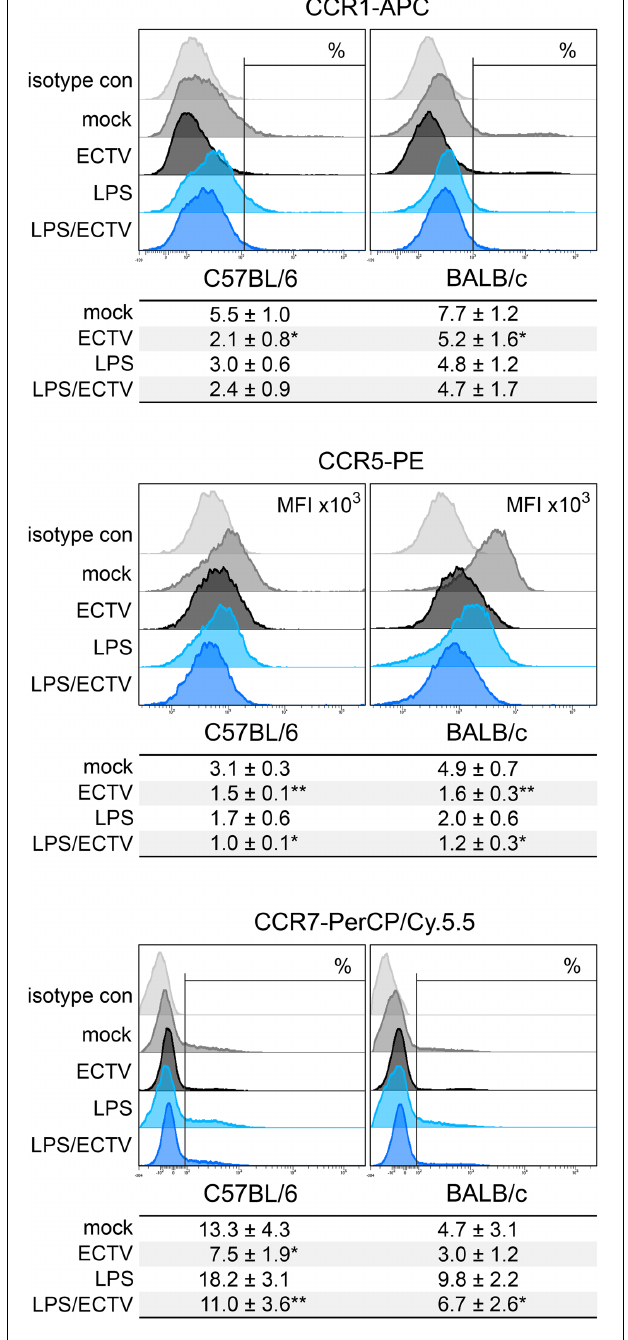
FIGURE 9 | ECTV infection similarly affects the expression of chemokine receptors on GM-BM from C57BL/6 and BALB/c mice. Representative flow cytometry histograms of chemokine receptor expression on GM-BM following the infection with ECTV and/or treatment with LPS at 24 hpi. Below each histogram set is a table with mean values ( ± SD) for a given marker from at least three independent experiments. The expression is presented as mean fluorescent intensity (MFI) or the percentage of positive cells for a given marker. Statistical comparisons were between mock- and ECTV-exposed DCs and between LPS- and ECTV + LPS-exposed DCs (paired Student’s t -test; ∗ P < 0.05, ∗∗ P <